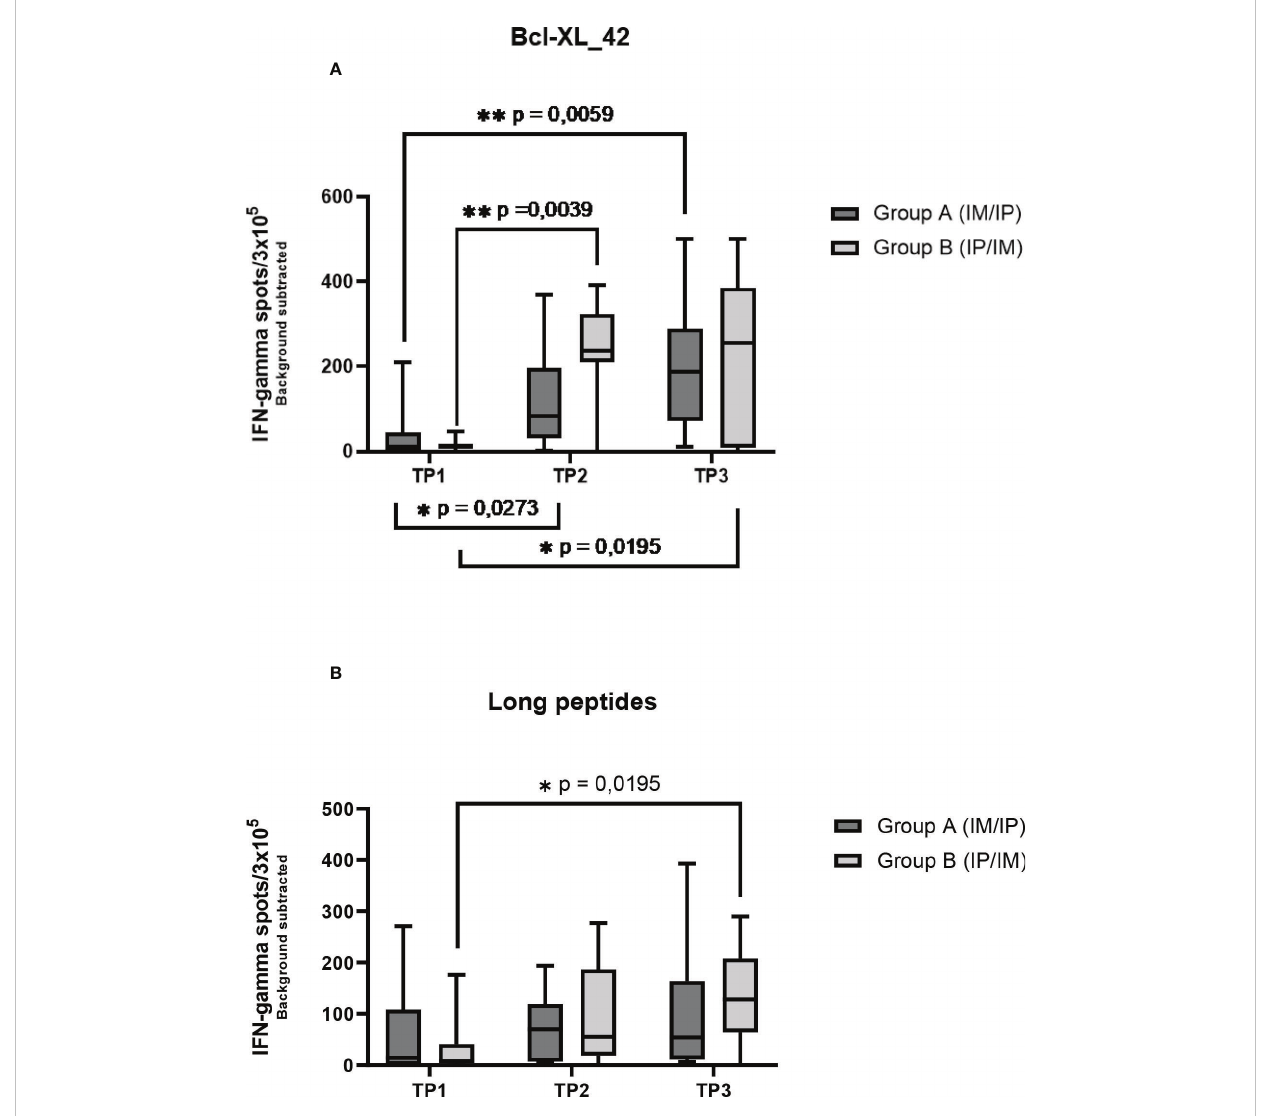
FIGURE 3 ELISPOT responses on PBMCs at three time points in two patient groups. Group A received three vaccinations IM fi rst and then IP. Group B received accinations IP fi rst and then IM. (A) the Elispot wells have been restimulated by the long peptide Bcl-XL_42, (B) and the HLA clas II predicted long peptide pool. Error bars depict the standard error of the mean. Statistical testing was performed using Wilcoxon matched pairs signed rank t-test. The stars are intended to fl ag levels of signi fi cance. If a p-value is less than 0.05, it is fl agged with one star (*). If a p-value is less than 0.01, it is fl agged with 2 stars